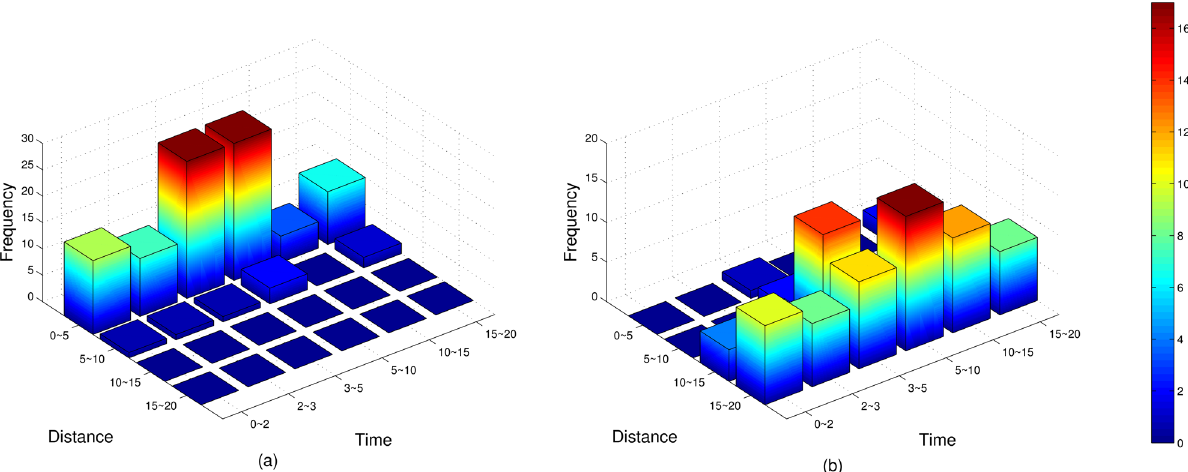
Fig 11. Using frequency of each proportion in Table 5 for instance E-n101-k14 according to different MaxY values. MaxY is set as 150 and 30 for (a) and (b) respectively.